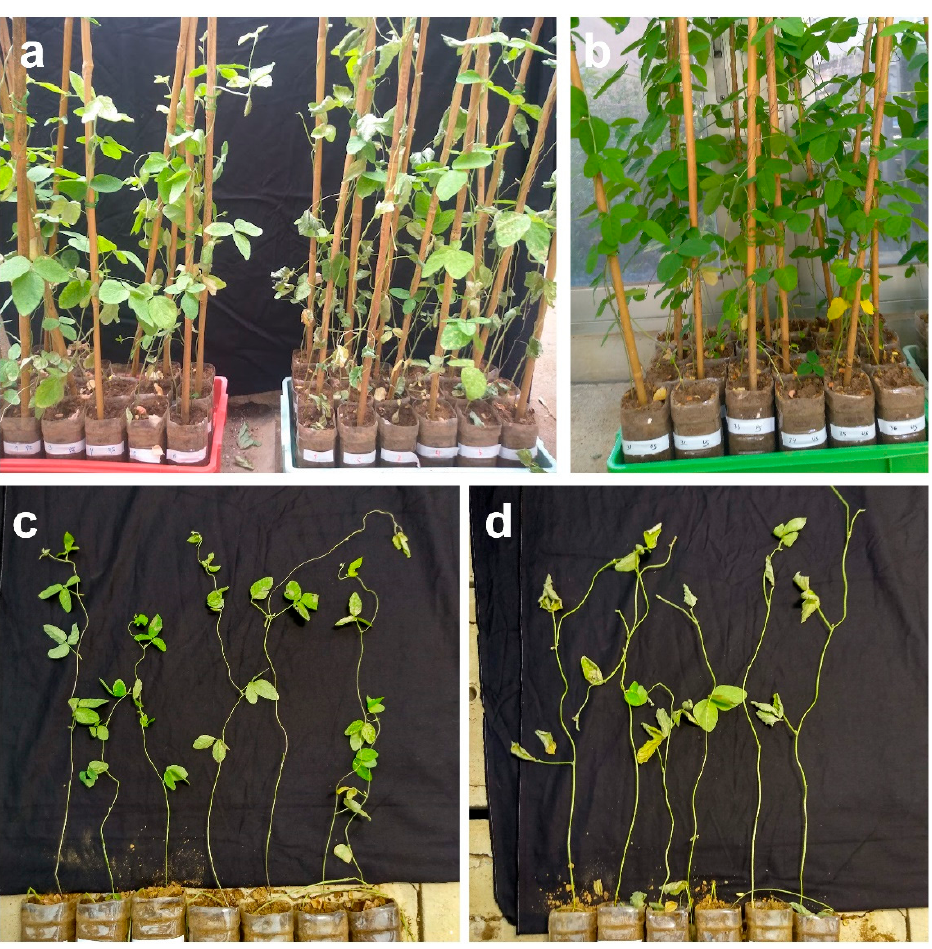
Figure 1. Phenotypes of the drought-sensitive soybean C08 plants after drought treatment. ( a ) Left: plants after 2 cycles of drought treatment (2S: 7 days without irrigation until the first sign of wilting, followed by 5 days of recovery and then 10 days without irrigation). Right: plants receiving only 1 cycle of drought treatment (1S: 10 days without irrigation with no priming). ( b ) Phenotype of un- stressed plants (US) well irrigated throughout the experiment. ( c ) The 2S plants laid out individually on a flat surface. ( d ) The 1S plants laid out individually on a flat surface.